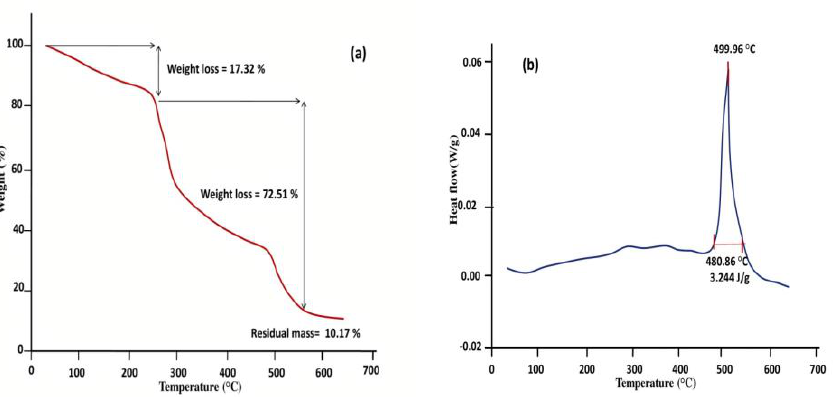
Figure 4. Thermal analysis ( a ) TGA, ( b ) DSC thermograms of purified